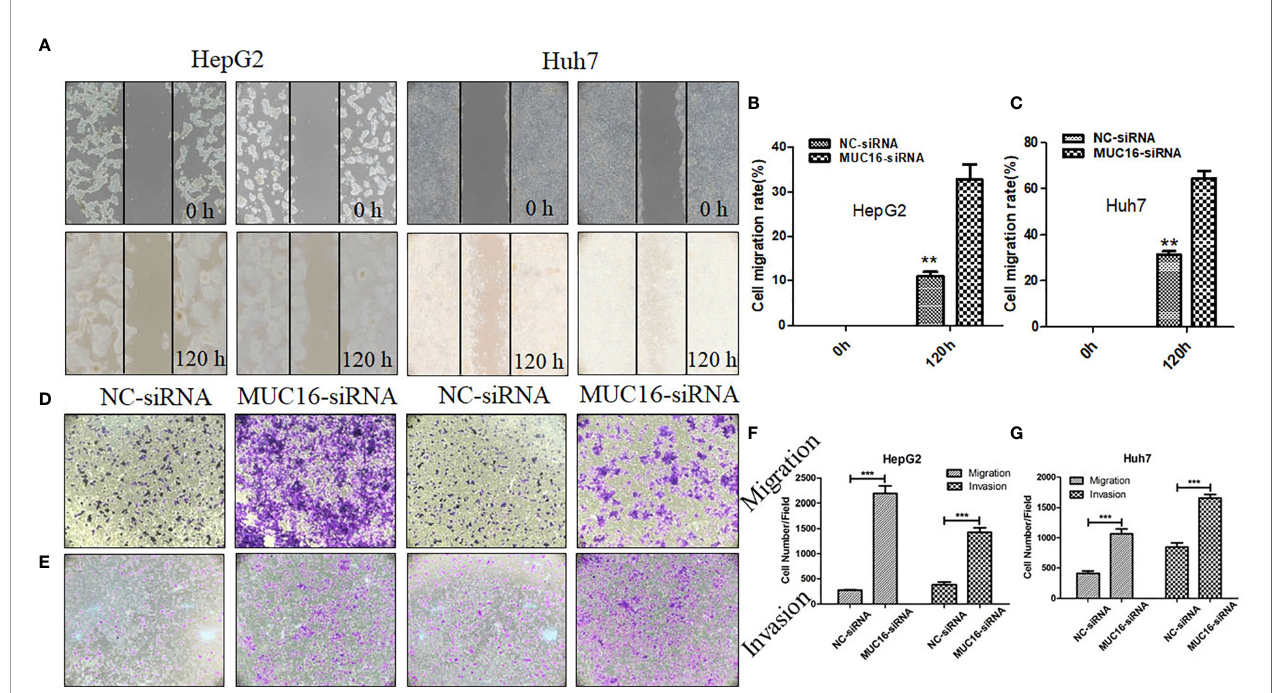
FIGURE 5 | MUC16 knockdown enhances cell migration and invasion. (A) Photographs of the scratch wounds made in the HepG2 and Huh7 cell layer showing that cellular motility was inhibited in MUC16-silenced cells compared with that of negative control cells and (B, C) the width of injury line after transfection for 72 h compared with 0 h was quanti fi ed. (D, E) Representative images of coated transwell chambers without (upper panel) or with (lower panel) HepG2 and Huh7 cells. (F) The number of cells that passed through the uncoated and precoated fi lters with Matrigel in HepG2 cells. (G) The number of cells that passed through the uncoated and precoated fi lters with Matrigel in Huh7 cells. The cell counts are presented as the mean number of cells per fi eld from at least fi ve randomly selected low-powered fi elds (200 X) from three independent experiments. Error bars represent the S.D. **, represents p < 0.01; ***, represents p <